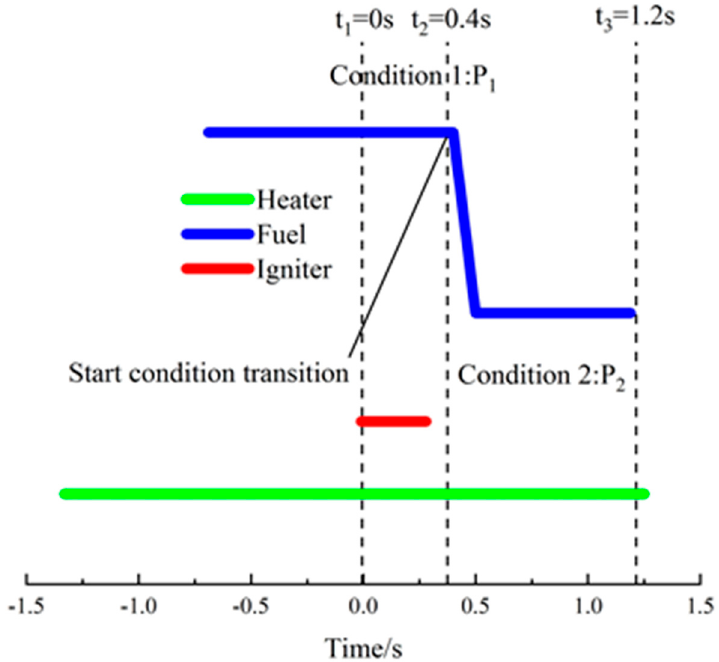
Figure 2. A typical time sequence of the experiment.